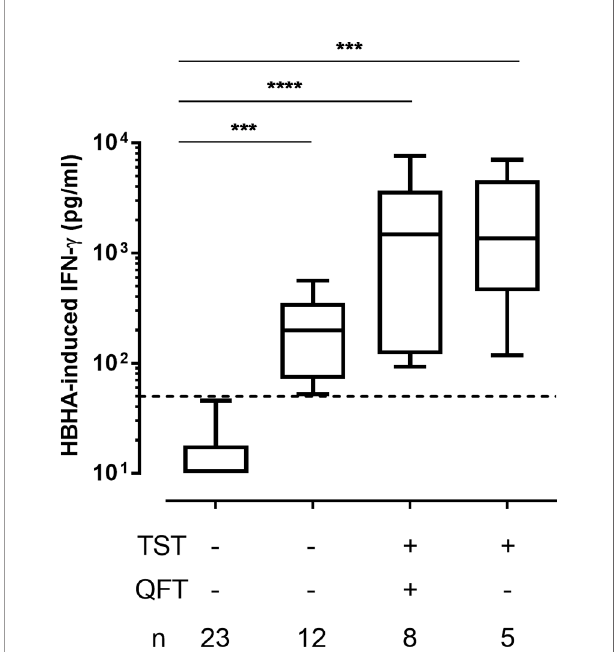
FIGURE 3 | HBHA-induced- IFN- g concentrations. IFN- g concentrations were measured in 24 h culture supernatants of PBMC incubated with HBHA. Patients were subdivided into 4 groups according to their TST and QFT status. Boxplots represent medians and interquartile ranges (25th-75th), with whiskers (min-max). Dotted lines indicate the positivity cut-off for HBHA-IGRA. ***p ≤ 0.001; ****p ≤